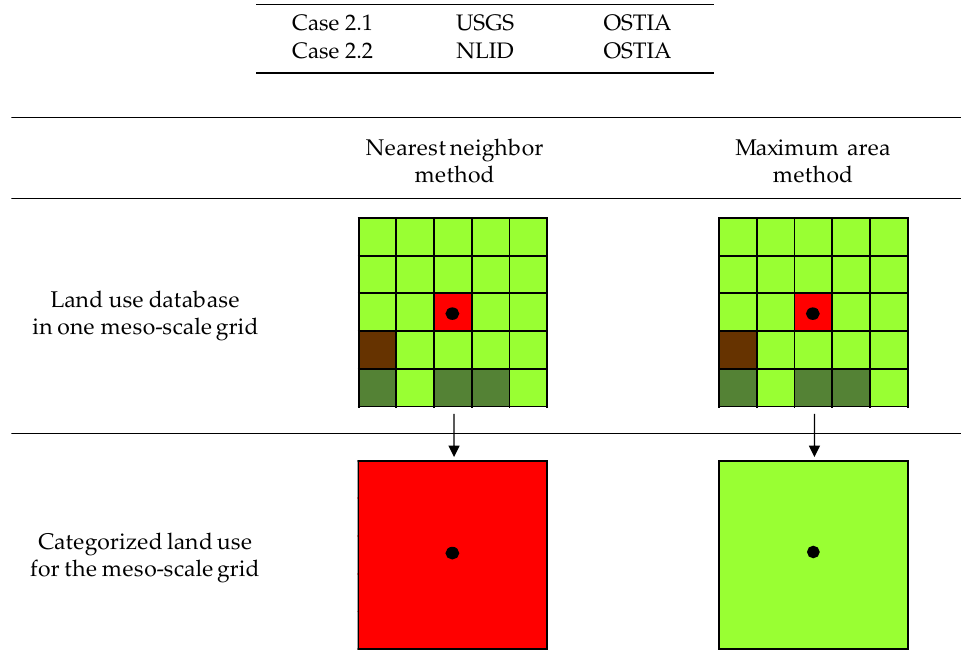
Figure 7. Comparison of each interpolation method for changing land-use datasets to mesoscale grids.